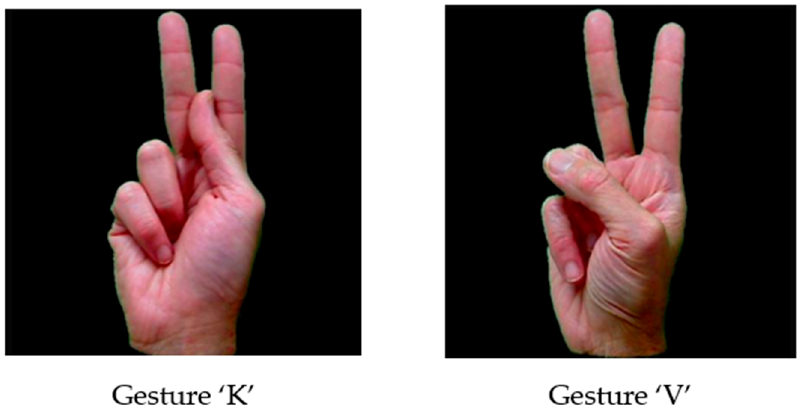
Figure 15. Similar gestures.